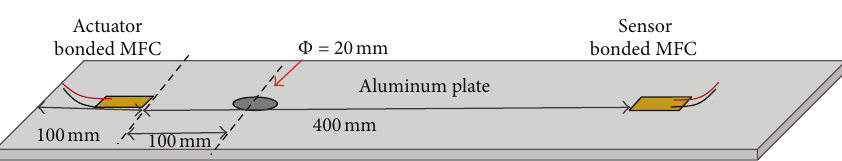
Figure 7: The specimen with circular defect and bonded MFC patches locations.